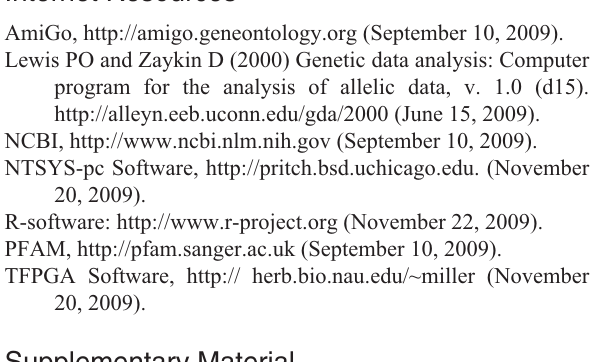
Table S1 - Functional annotation off SSRs sharing similarity with proteins in GenBank. Table S2 - SSRs with similarity to ESTs deposited in the dbEST